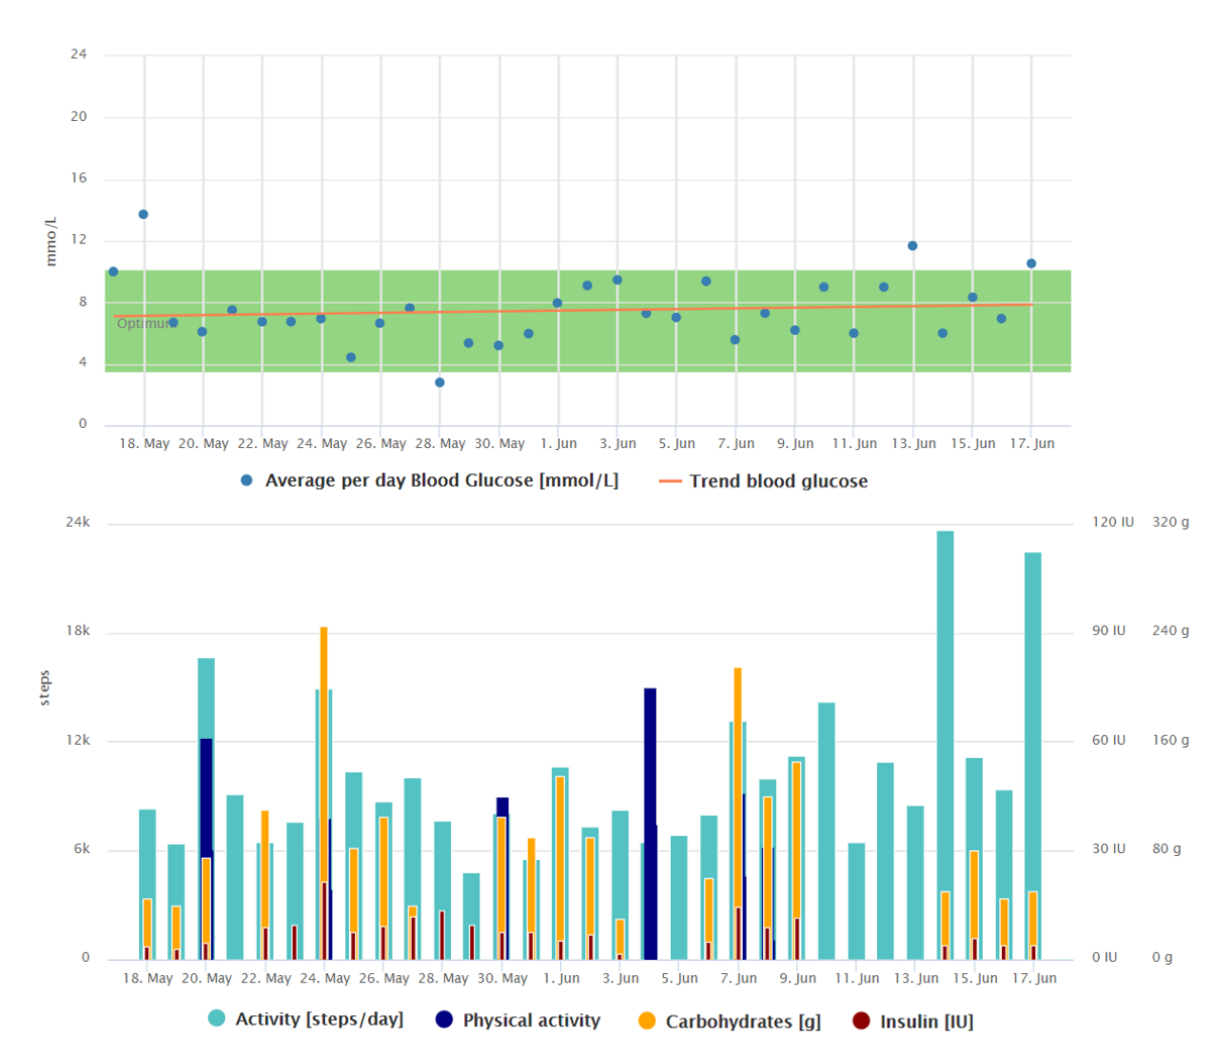
Figure 6. Graphical interpretation of 1-month data registrations of the patient from case study 4 after the patient got the activity tracker. The frequency of data registrations has increased, and the average blood glucose has decreased significantly compared with the average blood glucose trend in